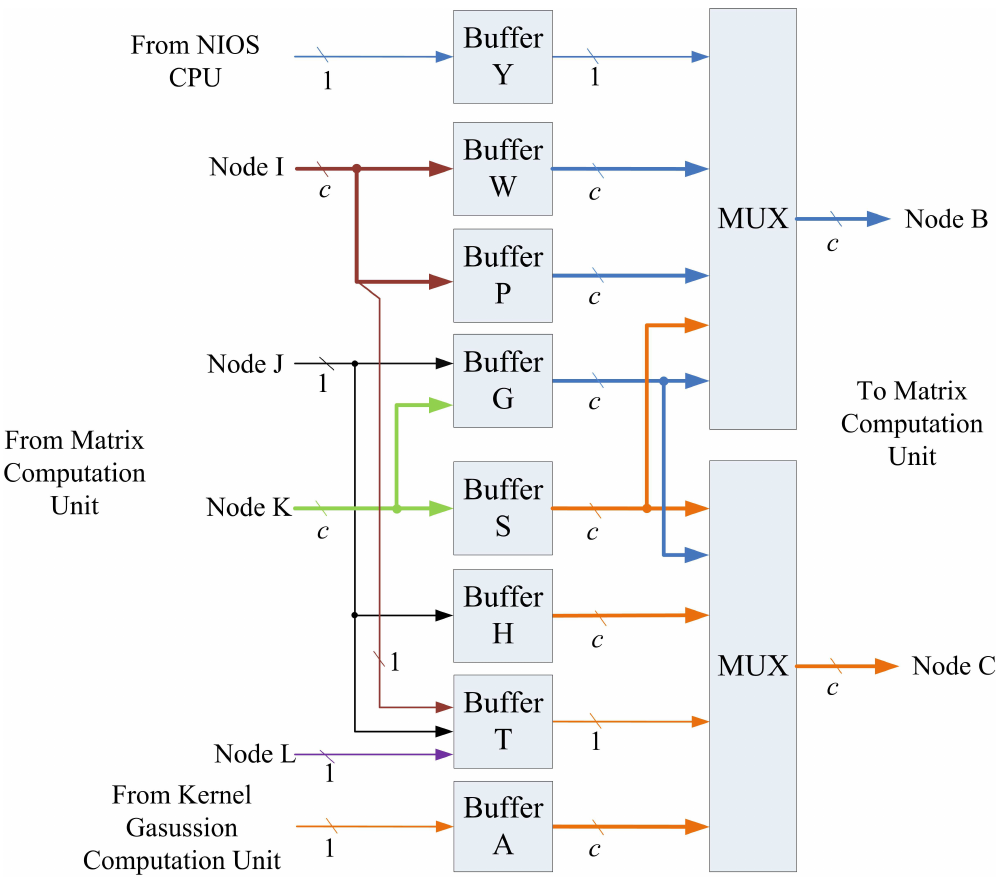
Figure 10. The architecture of memory unit.